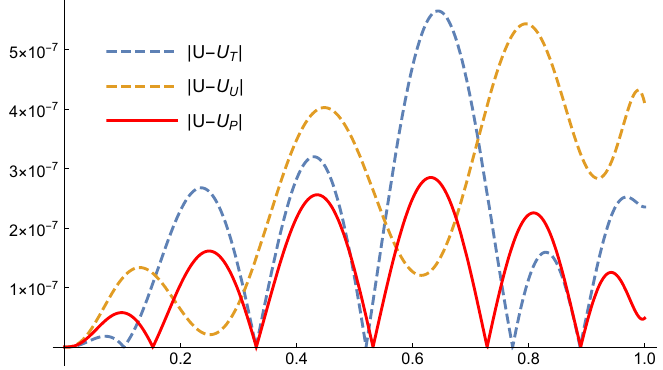
Figure 2. The absolute error between exact solution and u T , u P and u U